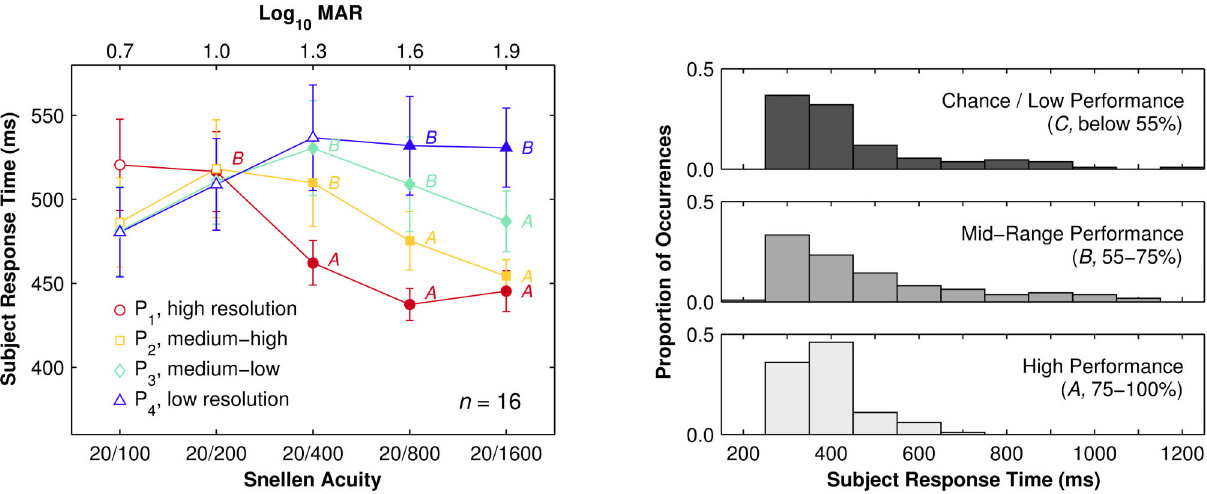
Figure 6. Response time results. (LEFT) Response time as a function of font size, grouped by pattern resolution. Population mean (symbols) and standard deviation (error bars) of subject average response time for correct trials for each condition. Filled symbols indicate conditions with statistically significant population hit rates. Annotations of A and B symbols indicate conditions with hit rates in Mid-Range and High-Performance ranges, respectively, while unannotated symbols are conditions in the Chance/Low-Performance range. High-Performance conditions all have faster population response times than Mid-Range conditions, whereas Chance conditions have intermediate values that are affected by font size but not pattern resolution, together suggesting that two different perceptual mechanisms were involved. (RIGHT) Distribution of response time broken down by hit-rate performance ranges. The three graphs depict the relative occurrences for mean response times per condition binned to 100 ms for data from Chance/Low-Performance (upper), Mid-Range (middle), and High-Performance (lower) conditions. A Kolmogorov-Smirnov test found no significant difference between the Low-Performance and Mid-Range data ( p =0.47), while a significant difference was found between the Mid-Range and High-Performance data ( p , 0.01). There is a strong functional difference between performing at versus above chance, guessing versus knowing the answer, despite no significant difference found between the respective distributions. In contrast, there is only a weak functional difference between the upper two performance ranges, reflecting a sliding degree of task difficulty, but the significant difference in distributions suggests the emergence of a distinct mechanism at upper performance levels.